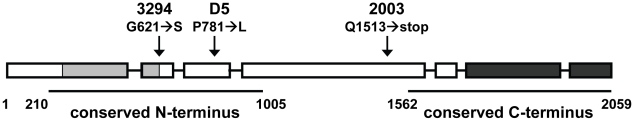
Schematic of the mus308 gene.Exons are represented by boxes. The helicase-like domain (light gray shading) and polymerase domain (dark gray shading) are shown. Locations of the D5, 3294, and 2003 point mutations are indicated with arrows (numbers correspond to amino acid positions in the protein). Not shown is the D2 mutation, which results in severely reduced levels of pol θ.